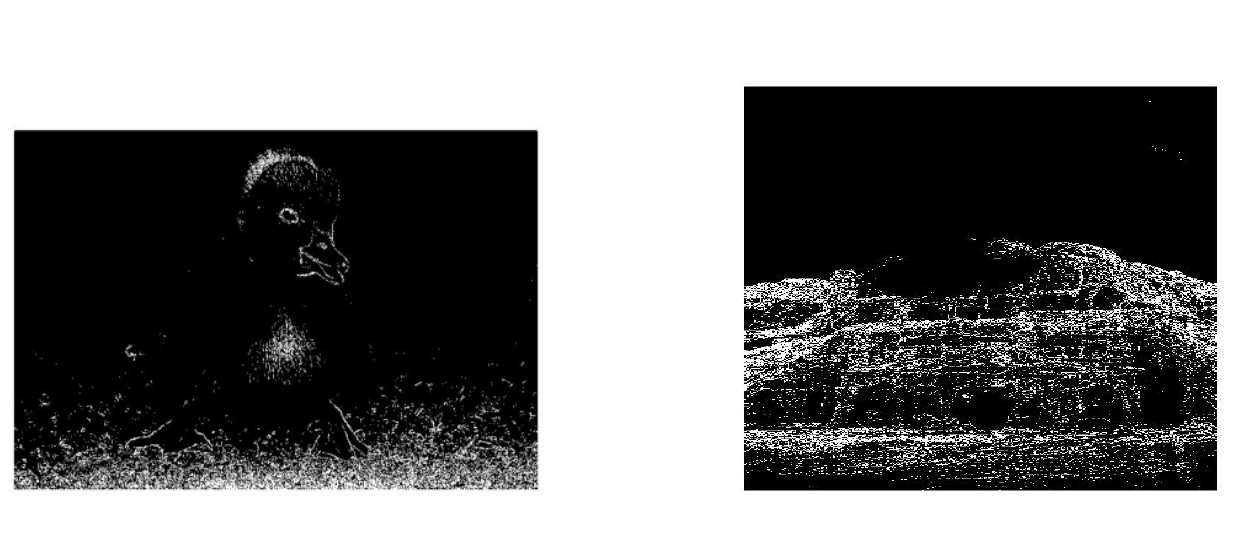
Figure 4.2 Segmented Duck Image